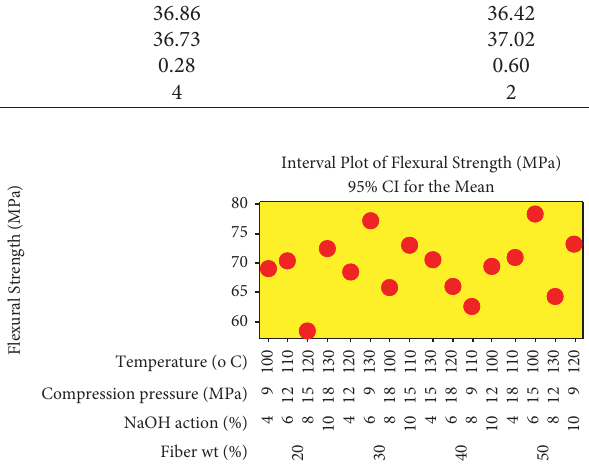
Figure 7: Interval plot used in flexural strength analysis.